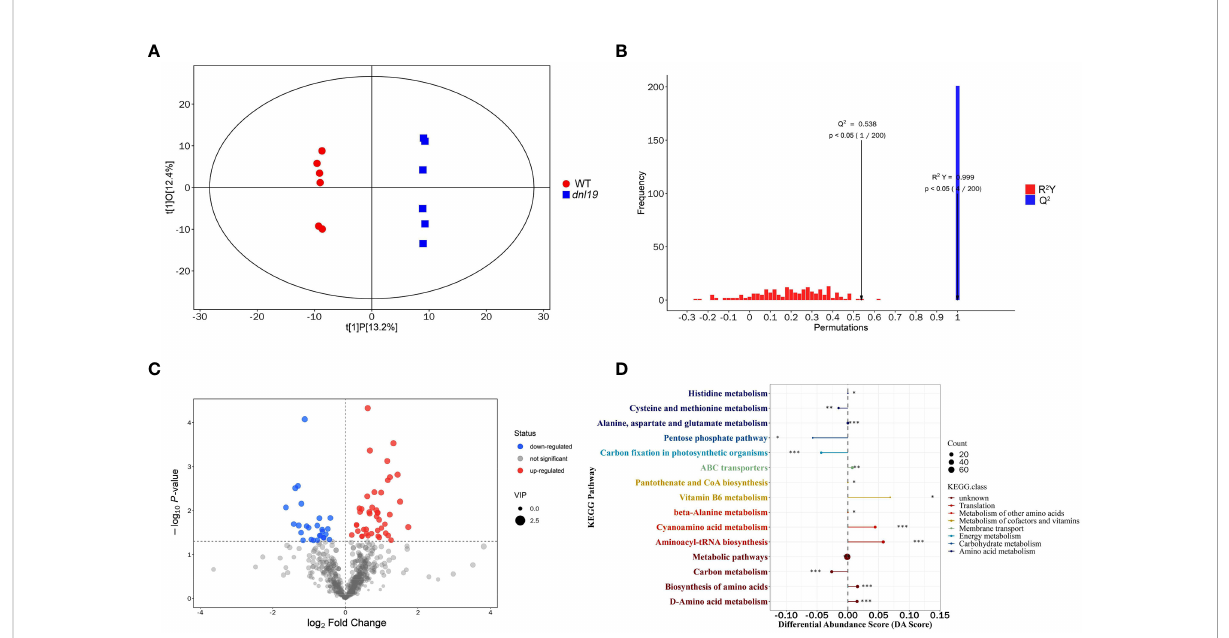
FIGURE 6 Widely targeted metabolomics analysis of dnl19 mutant. (A) Scatter plot of OPLS-DA scores for WT group versus dnl19 group. (B) Permutation tests of OPLS-DA model. The X-axis indicates the accuracy of the OPLS-DA model, and the Y-axis indicates the accuracy frequency of 200 models in 200 permutation tests. R 2 (Y) = 0.999, Q 2 = 0.538. (C) Volcano map of differential metabolites with VIP value ≥ 1 and P -value<0.05. The abscissa represents the fold change of each metabolite, and the ordinate represents the P -value by student ’ s t -test. (D) Analysis of overall changes of KEGG metabolic pathway. Each dot represents a metabolic pathway. The X-axis was the differential abundance (DA) score, and the Y-axis was the ID number of KEGG metabolic pathway. * represents signi fi cance. * P < 0.05, ** P < 0.01, *** P <